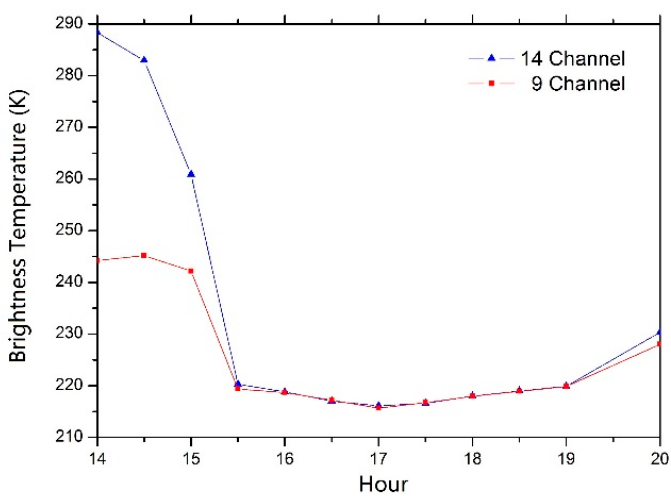
Figure 3. Time series variation of BTs in channels 9 (7.0 μ m) and 14 (11.2 μ m) transecting the main core of the hailstorm for the analyzed case study on 1 July 2021.